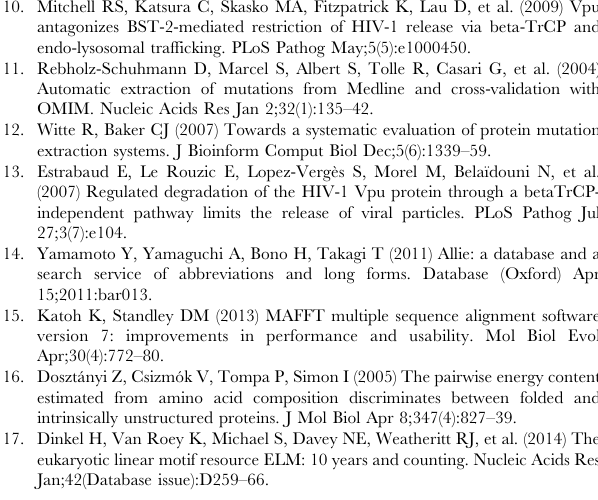
Table S1 Regular expressions for mutation identifica- tion and harmonization. A list of templates/regular expres- sions, based on the work of Caporaso et al. [5], used to search the publications for sentences describing mutagenesis experiments or